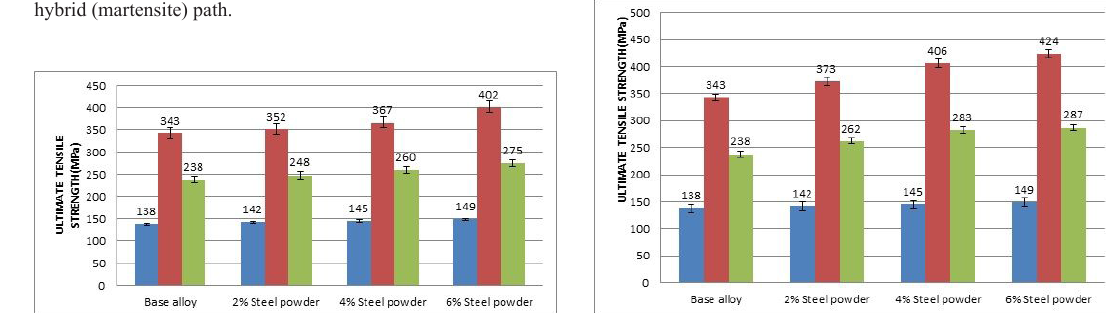
Figure 9. Peak hardness of Al 7075 eutectoid steel composite in hybrid (martensite) path.